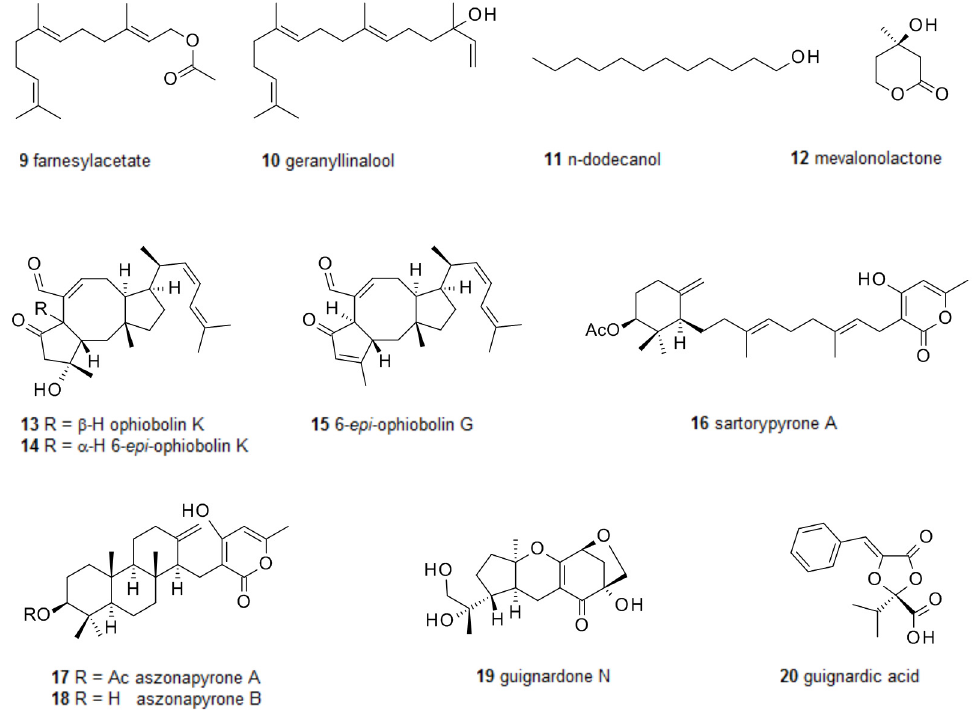
Figure 2. Terpene-derived secondary metabolites from fungi reported to inhibit biofilms of bacteria or fungi, and related